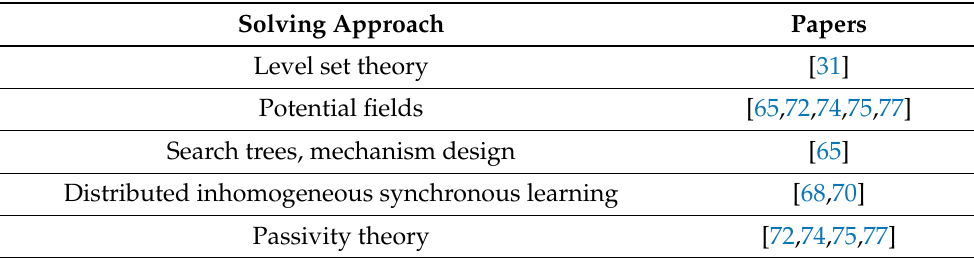
Table 4. Approaches to solving coordination games and papers which use